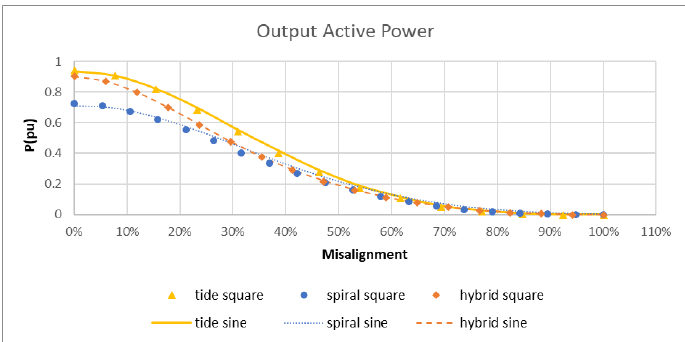
Figure 22 Figure 22. Measured output active power for pure resistive